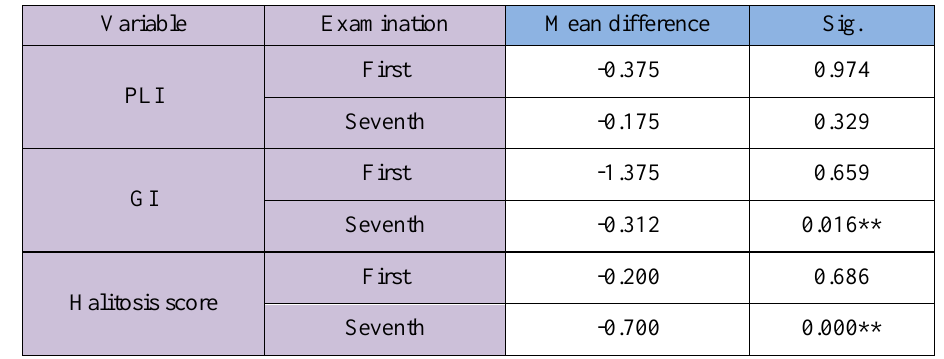
Table 4: Multiple comparisons by Scheffe